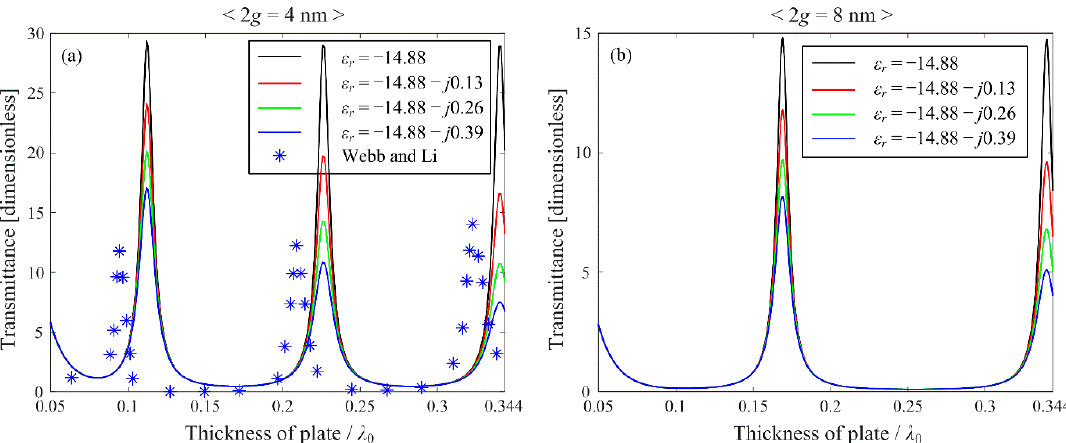
Figure 3. Transmittance as a function of Ag plate thickness: ( a ) 2 g = 4 nm; ( b ) 2 g = 8 nm. The blue asterisks are remarked from [29], when ε r , m = –14.88 – j 0.39.